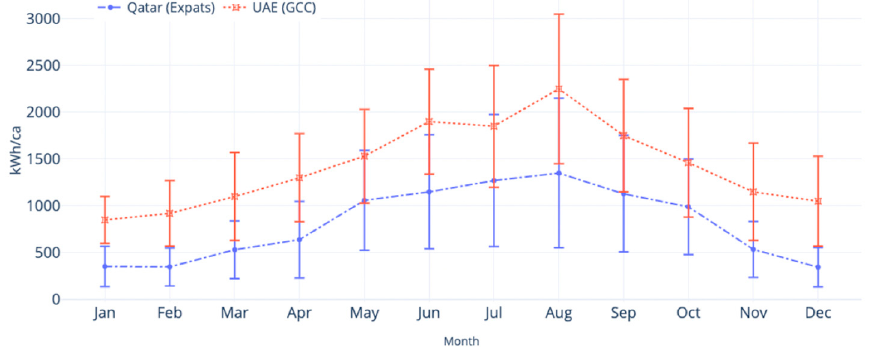
Figure 10. Comparison of monthly mean per capita monthly energy consumption for 10 selected houses in Qatar and Abu Dhabi (bars indicate standard deviation).